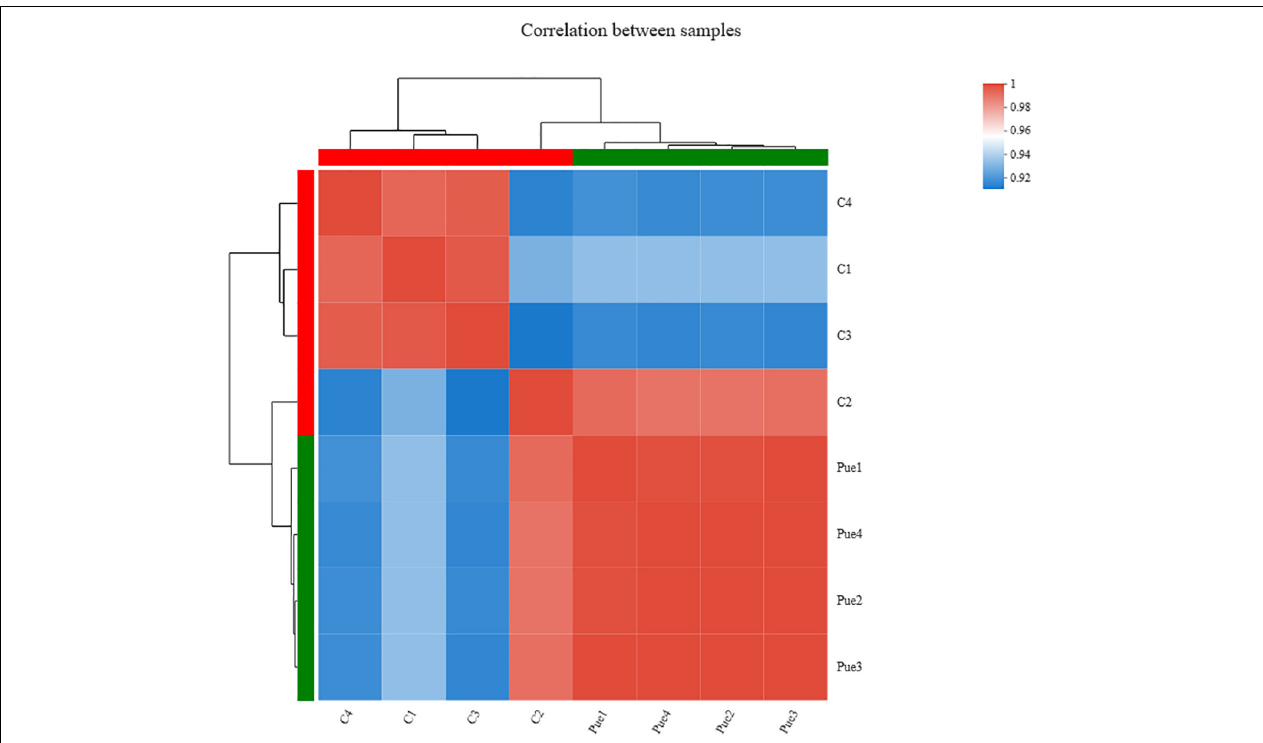
FIGURE 2 | Correlations of eight samples ( n = 4). C1, C2, C3, C4 were four samples of the Control group (dietary supplementation with 0 mg/kg Puerarin in the feed concentrate), and Pue1, Pue2, Pue3, Pue4 were four samples of the Pue400 group (dietary supplementation with 400 mg/kg Puerarin in the feed concentrate). In the figure, the right and lower sides are the sample names, the left and upper sides are the sample clustering, and the different color squares represent the correlation of the two